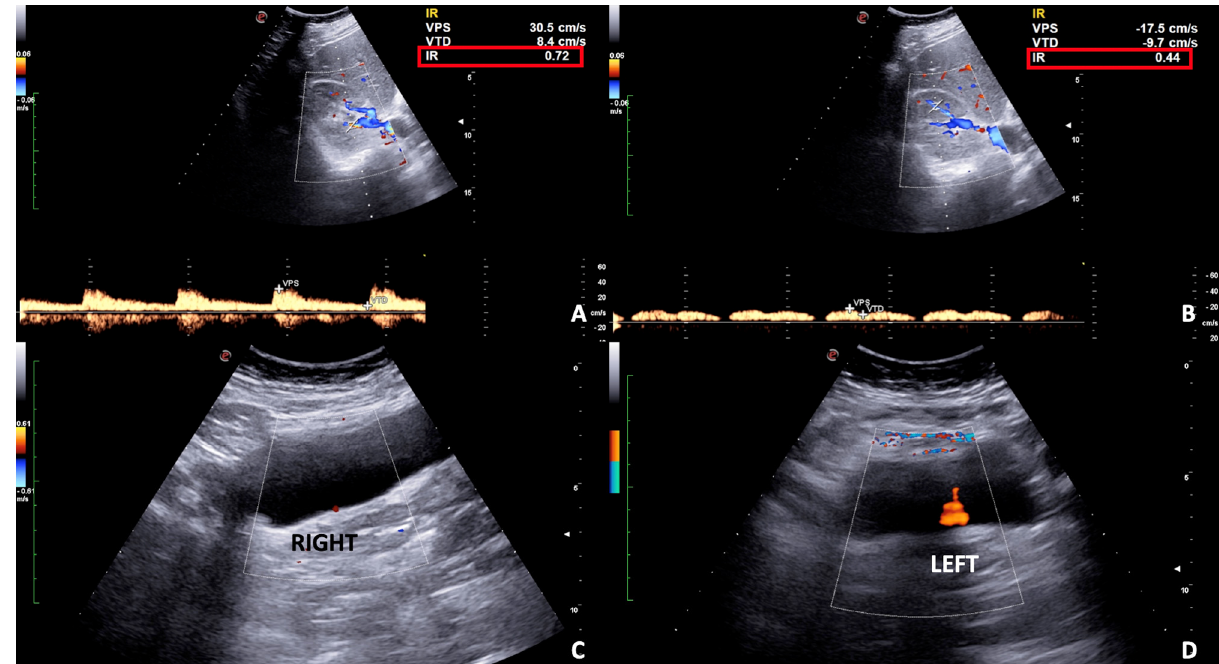
Figure 8. US B-mode ( A , B ) and Colour Doppler ( C ) scans in pregnant woman with right flank pain and nausea. ( A ) Collecting system of the right kidney is dilated with evidence ( B ) of a calculus (ar- row) in the middle tract of the lumbar ureter resulting in complete urinary obstruction and mild